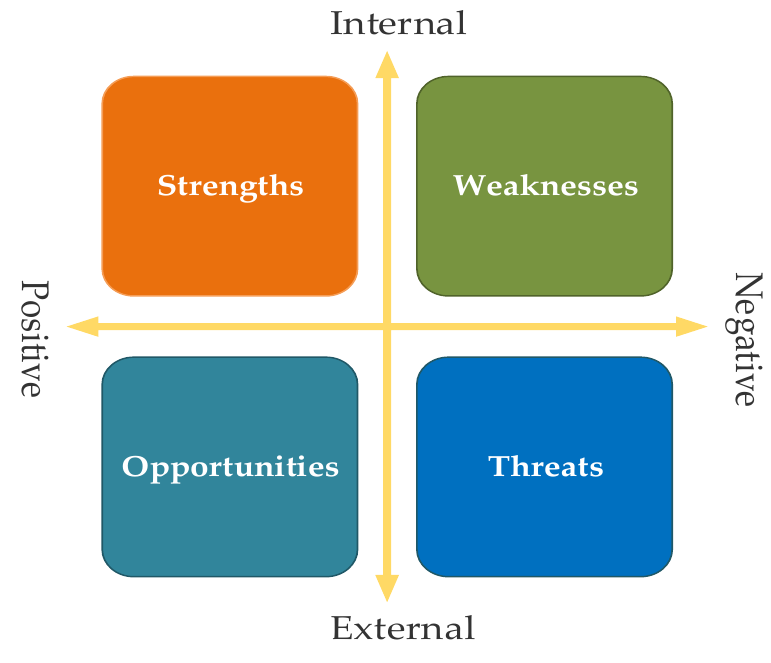
Figure 1. Typical SWOT analysis matrix.